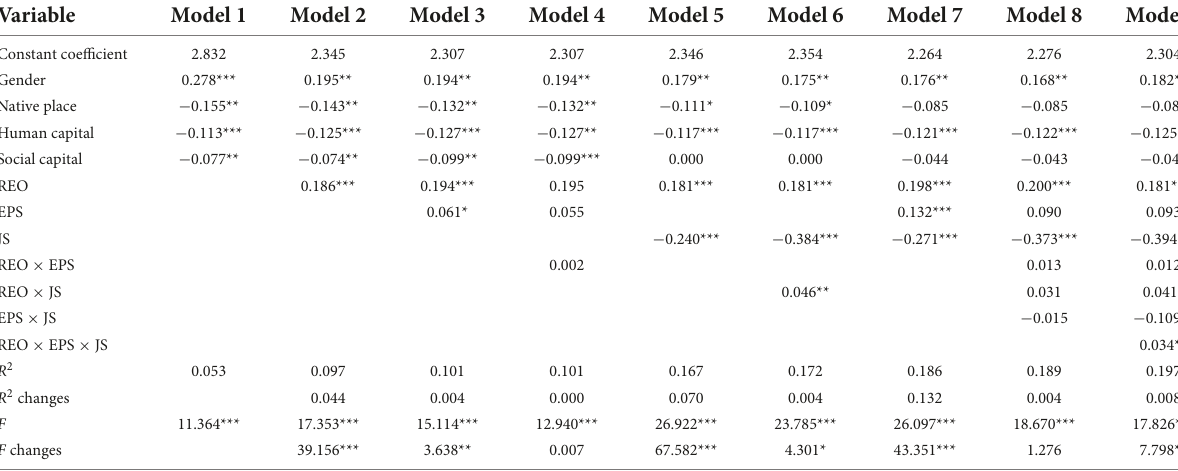
TABLE 4 The moderating effect of employment policy support and job-searching self-efficacy on the relationship between perception reduction of employment opportunities and self-pressure. Dependent variable: Self-pressure